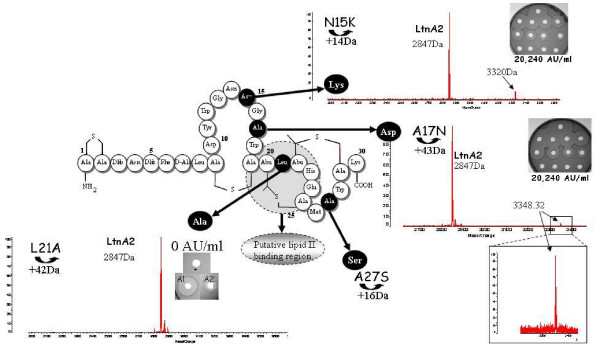
Site directed mutagenesis of the structural backbone of the lantibiotic peptide LtnA1. Mutants N15K, A17N and L21A are indicated by arrows. Well diffusion assays indicating the activity (AU/ml) of concentrated purified supernatants of the mutants (Varian C18 column) and mass spectrometry profiles accompany each mutant generated. The scale on the y-axis of the mass-spec is L21A: 2000–3700 mass/charge, A17N: 2700–3400 mass/charge, N15K: 2000–3600 mass/charge. The Mutant L21A has no activity (0 AU/ml), the + indicates that this mutant was combined with LtnA1 and LtnA2, and a complementation effect was evident with LtnA1. The mutant A27S could not be generated but represents the fourth amino acid difference between staphylococcin C55α and LtnA1. The shaded broken circle represents the putative lipid II binding region of LtnA1.